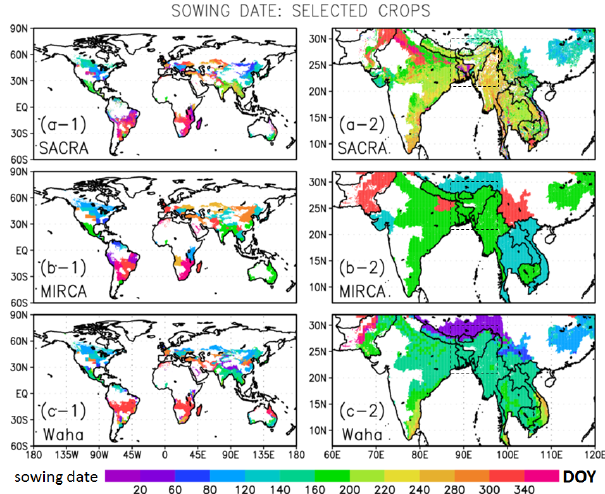
Figure 9. Sowing dates (unit: day of year) of dominant crops in the major cultivation season for (a) SACRA, (b) MIRCA2000, and (c) Waha et al. (2012). Left panels (a-1, b-1, and c-1) and right panels (a-2, b-2, and c-2) show global and South Asian maps, re- spectively. Sowing dates are illustrated in grids where the dominant crop is temperate-wheat, snow-wheat, maize, rice, soybean or cot- ton. The major seasons at multiple cropping grids are determined by Eq. (7) for SACRA. Panels of SACRA contain sowing dates of the major cultivation season for both single and multiple cropping grids. Boxes in right panels represent the area where SACRA did not detect the crop calendar in some grids while MIRCA2000- and Waha et al.